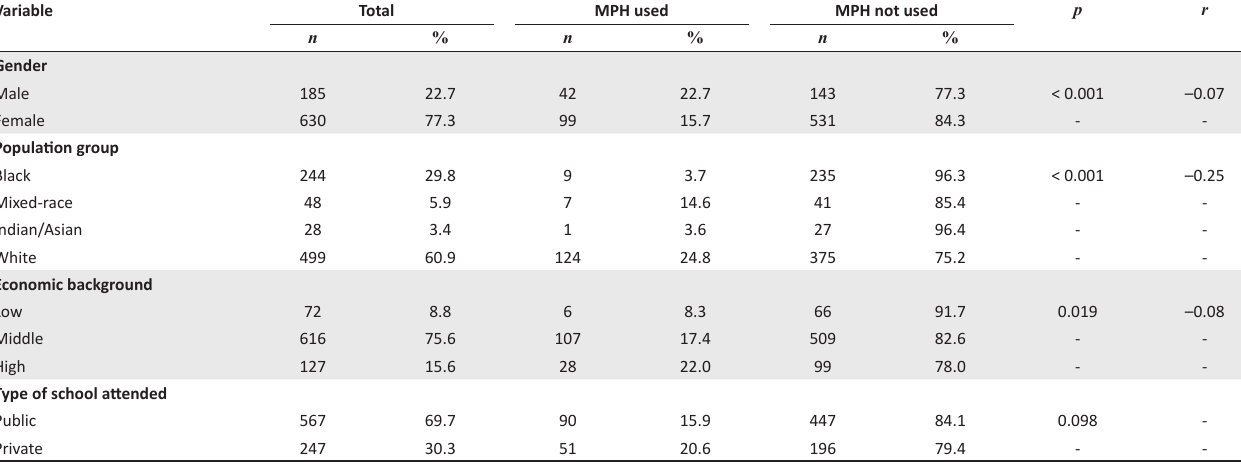
TABLE 1: Background characteristics of respondents and methylphenidate use.